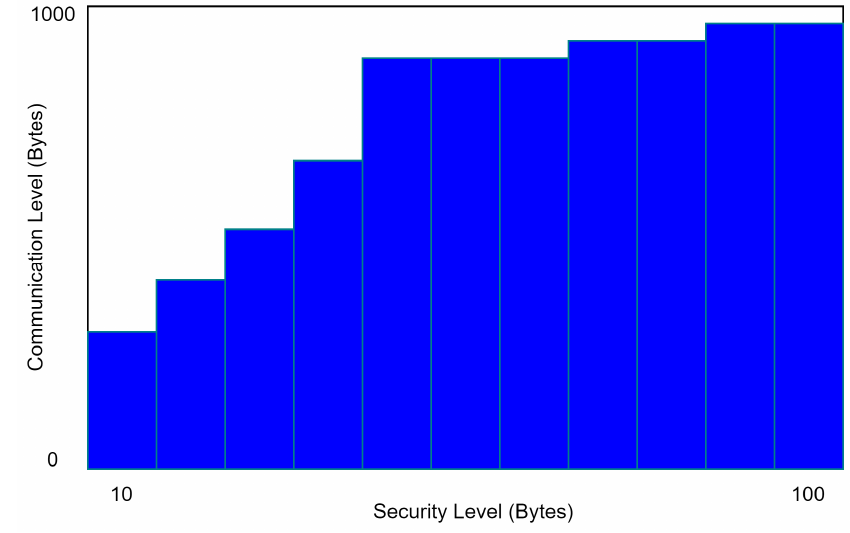
Figure 5. Performance of the proposed system in communication.